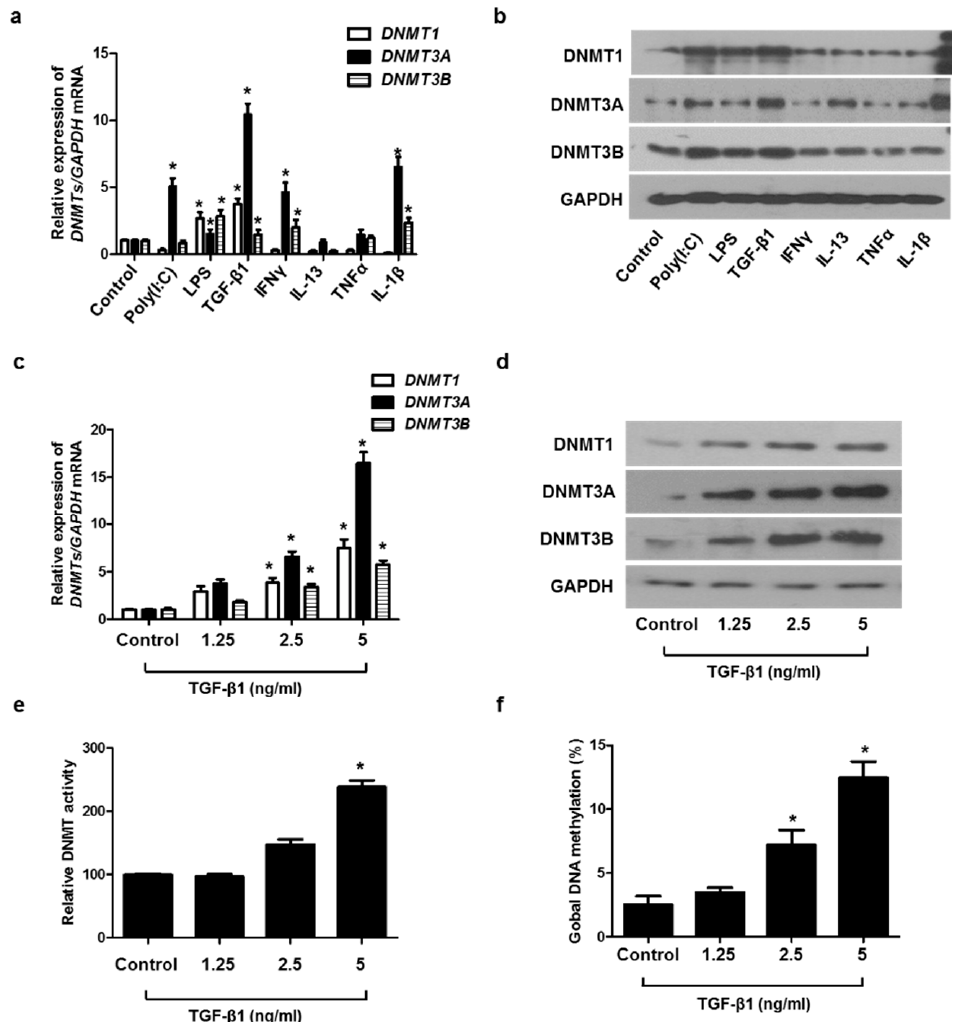
Figure 2. TGF- β 1-induced DNMT expression in A549 cells: ( a ) DNMT mRNA and ( b ) protein expression were measured using real-time PCR and Western blotting, respectively, in A549 cells after stimulation with Poly IC (10 µ g/mL), LPS (10 ng/mL), TGF- β 1 (5 ng/mL), IFN- γ (100 ng/mL), IL-13 (10 ng/mL), TNF- α (50 ng/mL), and IL-1 β (10 ng/mL) for 24 h; ( c ) real-time PCR analyses of DNMT1, DNMT3A, and DNMT3B revealed dose-dependent effects in mRNA expression following TGF- β 1 treatment; ( d ) protein expression of DNMT1, DNMT3A, and DNMT3B with TGF- β 1 treatment in a dose-dependent manner was measured using Western blotting; ( e ) DNMT activity and ( f ) global DNA methylation with TGF- β 1 treatment in a dose-dependent manner were detected using a Global DNA Methylation Assay Kit and DNMT Activation Assay Kit. Data are expressed as the mean ± SEM of three independent experiments using a single A549 cell line. * p < 0.05 vs.